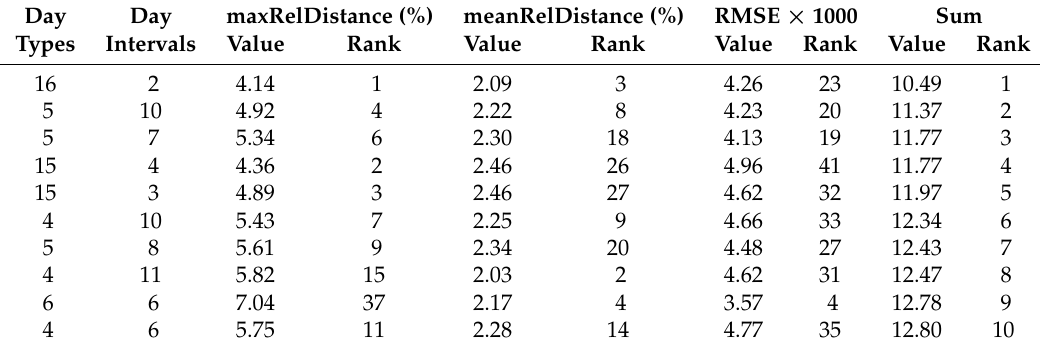
Table 8. Top model configurations for Golden: ranking by sum of three